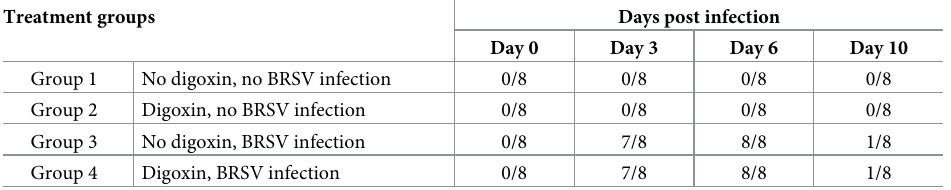
Table 1. Virus isolation results from nasal swabs collected on day 0, 3, 6 and 10 after infection. Treatment groups